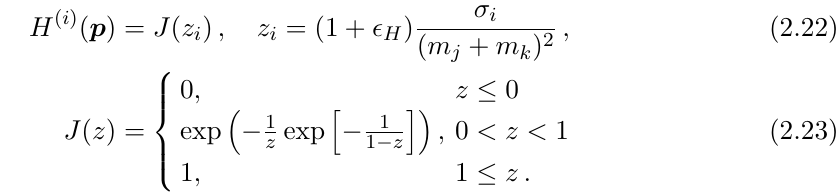
decreases monotonically until the point where σ 2 ,p 2